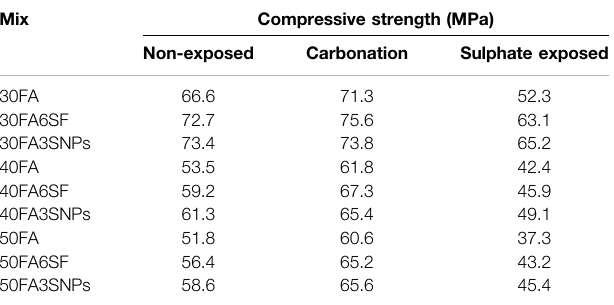
TABLE 3 | The compressive strength of carbonation, sulphate exposed and non- exposed 30%, 40%, and 50% fl y ash containing 3% SNPs and 6% SF incorporated concrete samples after 365 days of exposure.